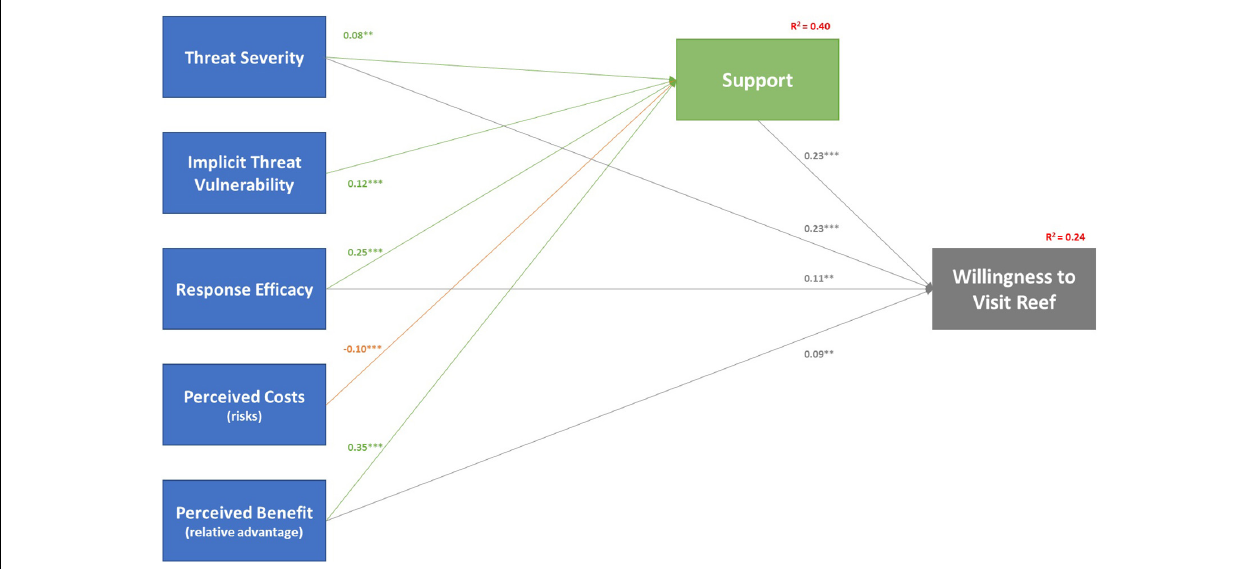
FIGURE 4 | Partially mediated path model ( R 2 = 0.46), showing direct and indirect effects of psychological correlates (blue boxes) on attitudinal intention to support the technology (green box) and behavioral willingness to visit the reef (gray box). Green arrows and blue arrows represent a direct positive relationships between psychological correlates and the dependent variables; orange arrow represents a direct negative relationship between psychological correlates and “intention to support”; and the gray arrow represents a mediated relationship between the dependent variables. ** refers to significance at the p < 0.01 and *** refers to significance at the p < 0.001